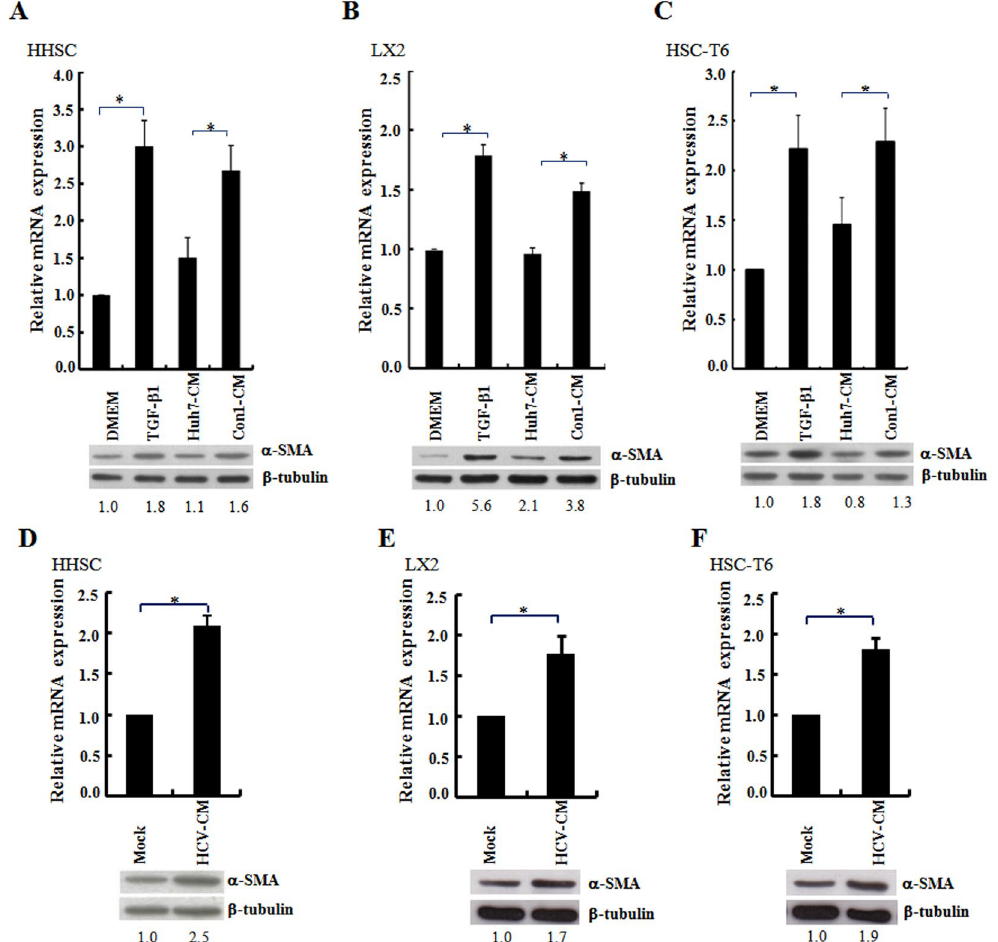
Figure 1. Conditioned medium from the culture of HCV replicon cells or HCV-infected cells increased procollagen I transcripts and α -SMA protein expression in HSC. ( A–F ) The HSCs of HHSC (panels A and D), LX2 (panels B and E) and HSC-T6 (panels C and F) were incubated with the conditioned medium (CM) derived from the 72 h culture of Huh7 and Con1 replicon cells (panels A,B and C), or the Huh7 cells infected with HCVcc (JFH1, MOI = 3; panels D,E and F). The level of procollagen I gene expression was quantified by real-time RT-PCR and the expression of β -tubulin was used as a control for normalization. Histograms were used to show the relative expression levels of procollagen I mRNA among different treatments. The cells cultured in DMEM without any treatment were arbitrarily denoted as 1. The data represent the mean ± S.D. (n = 3; * p < 0.05). In parallel, the cell lysates were harvested and Western blot analysis was performed using the anti α -SMA antibody. The ratios for the relative band intensities of α -SMA normalized by the expression of β -tubulin are shown at the bottom. HSCs cultured in the DMEM or DMEM supplemented with TGF β 1 (10 ng/ml) were used as the negative and positive control, respectively. The full Western blot and the corresponding positions of the molecular weight protein markers are presented in Supplementary Fig.